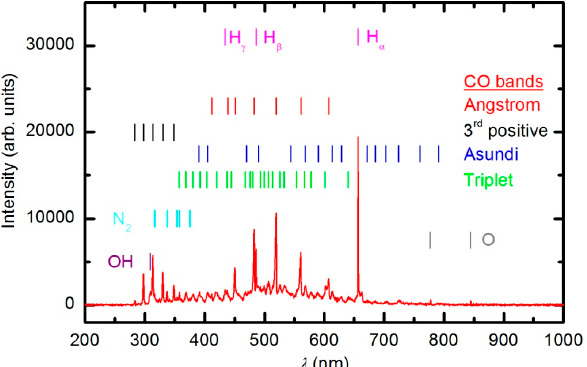
Figure 7. OES spectrum after 600 s of plasma treatment at 33 Pa and forward power of 150 W.